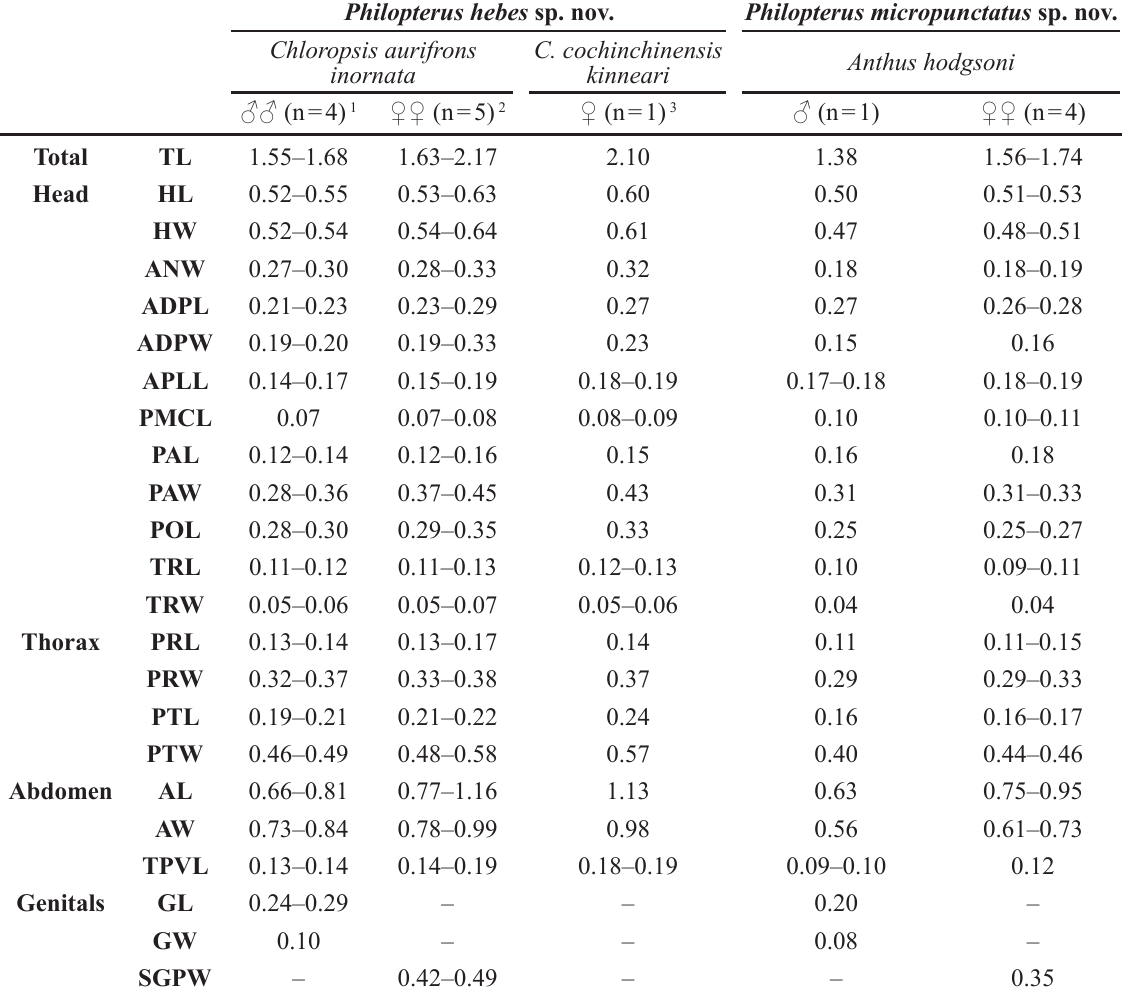
Table 1. Measurements (in millimetres) of Philopterus hebes sp. nov. and P. micropunctatus sp. nov. Some dimensions (e.g., APLL, TPVL) are measured on both sides of the body, and intervals may therefore be given even if only one specimen was examined. Abbreviations: ADPL = dorsal anterior plate length (at midline); ADPW = dorsal anterior plate width; AL = abdominal length (at midline); ANW = anterior notch width; APLL = dorsal anterior plate lateral length; AW = abdominal width (at segment V); GL = genital length (in male); GW = genital width (in male); HL = head length (at midline); HW = head width (at temples); PAL = preantennal length; PAW = preantennal width (at base of coni); PMCL = premarginal carina length; POL = postantennal length (at midline); PRL = prothoracic length; PRW = prothoracic width; PTL = pterothoracic length (at midline); PTW = pterothoracic width; SGPW = subgenital plate width (in female); TL = total length (at midline); TPVL = tergal plate V length; TRL = trabeculum length; TRW = trabeculum Philopterus hebes sp. nov.